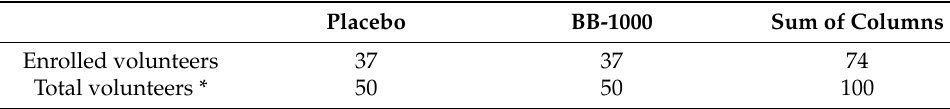
Table 2. Number of volunteers for clinical trials.